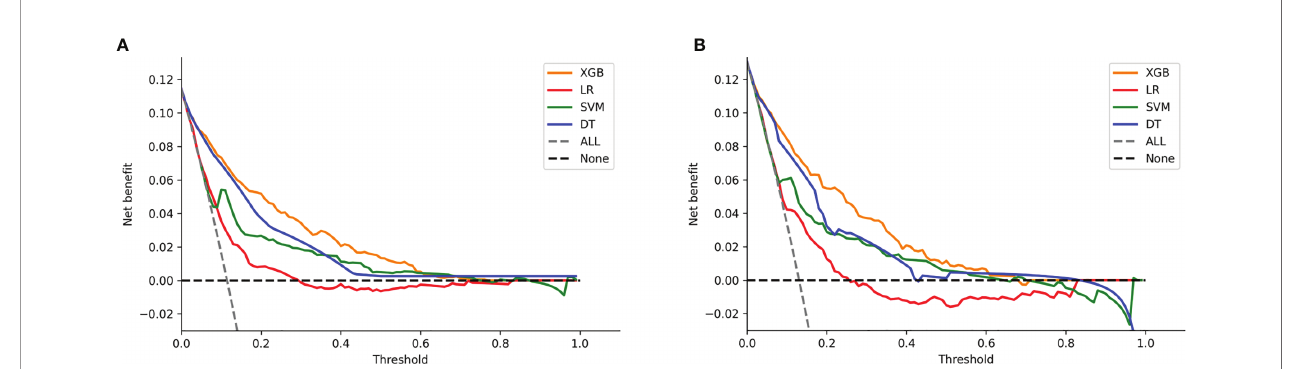
FIGURE 7 | Decision curve analysis graph showing the net bene fi t against threshold probabilities based on decisions from model outputs. Three curves were obtained based on predictions of the four different models, and the two curves obtained were based on two kinds of extreme decisions. The curves referred to as “ All ” represent the prediction that all the patients would progress to LNI, and the curves referred to as “ None ” represent the prediction that all the patients were nLNI. (A) The training set, and (B) the test set.